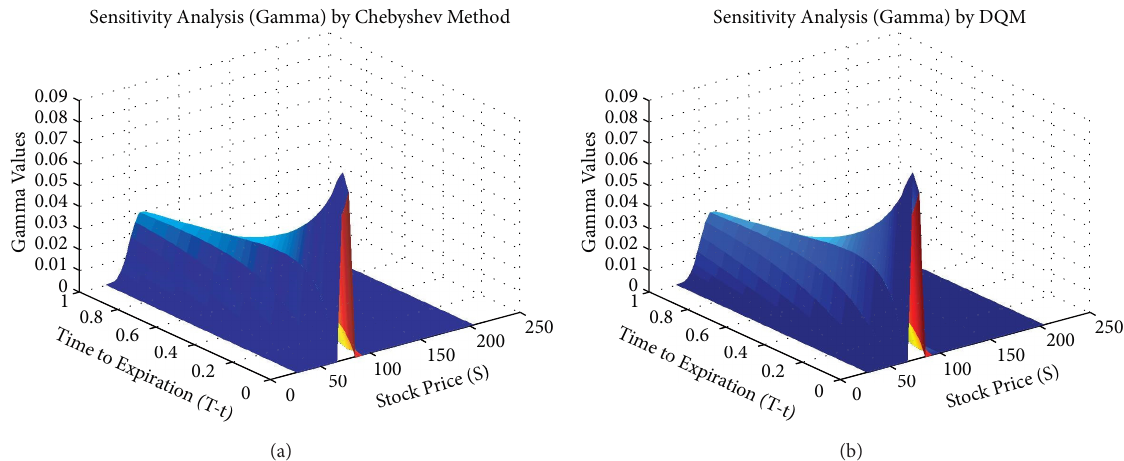
Figure 13: Sensitivity analysis (gamma) by Chebyshev spectral method (a) and by differential quadrature method